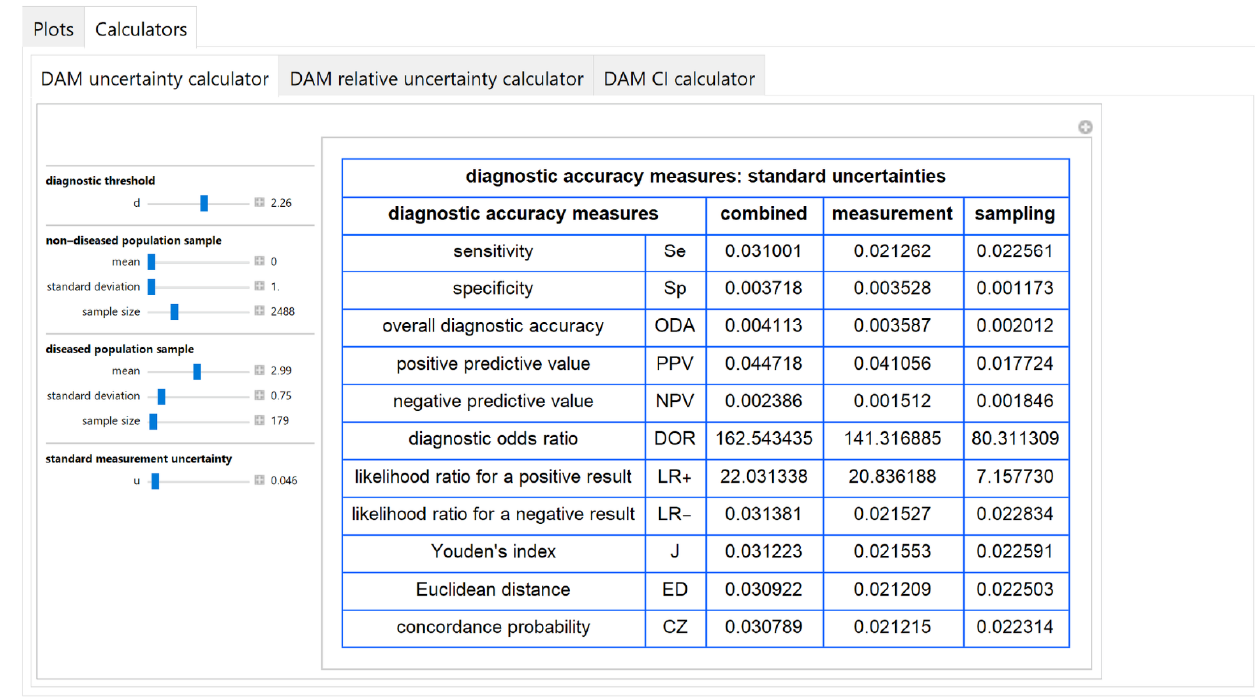
Figure 12. Calculators module, DAM uncertainty calculator submodule screenshot. Calculated standard combined, measurement and sampling uncertainty of diagnostic accuracy measures, with the settings shown on the left. The respective parameter settings are also shown in Table 3.